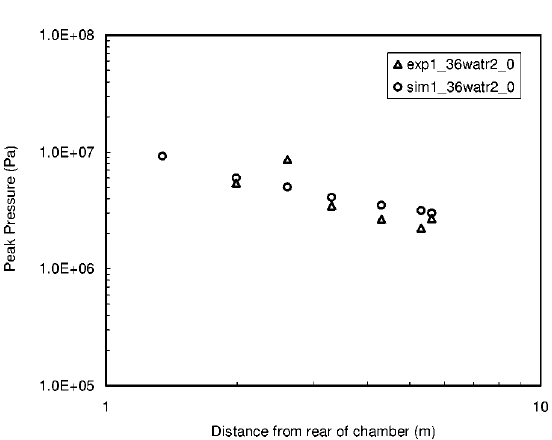
Fig. 9. Comparison between experiment and computation for 1.36 kg C4 charge detonation with water ( R = 1 : 3).